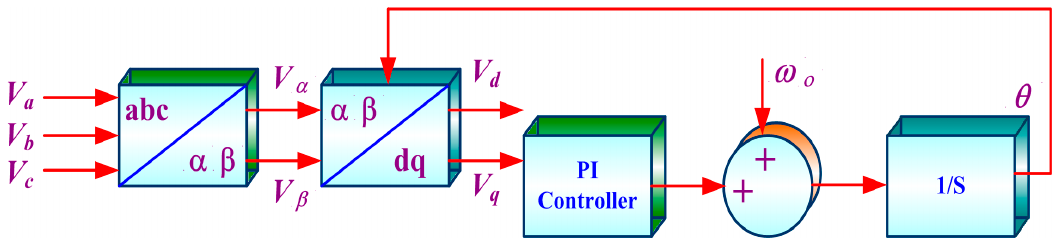
Figure 5. Synchronous Reference Frame (SRF)/ d-q PLL Structure.